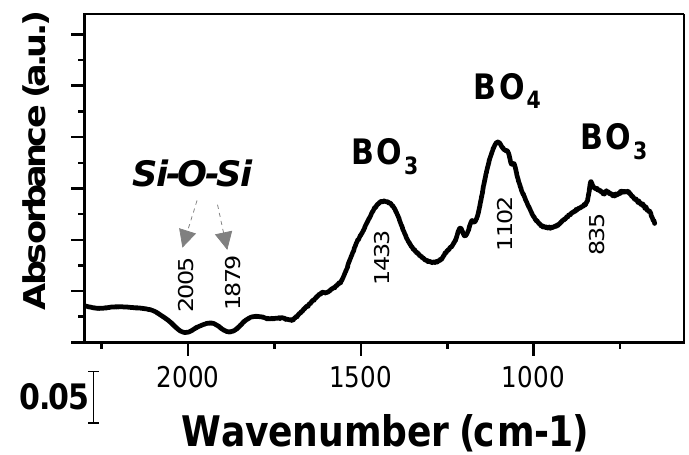
Figure 2. FTIR spectrum for aluminum borate (Al 18 B 4 O 33 ), which was obtained by processing the single beam spectrum using a KBr reference spectrum.